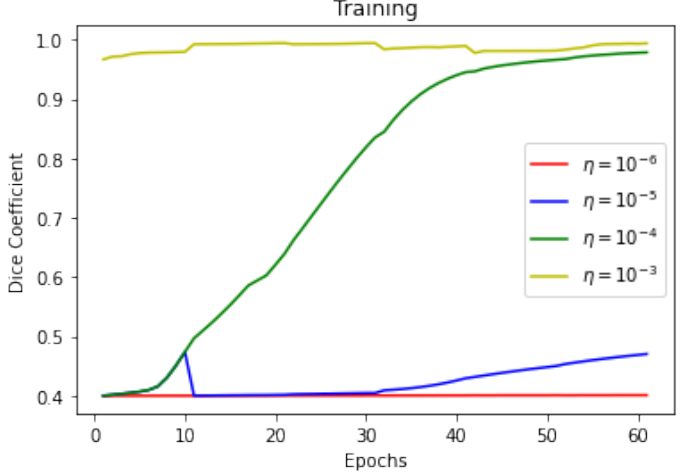
Figure 13. Training Dice Coefficient with Different Learning Rates.